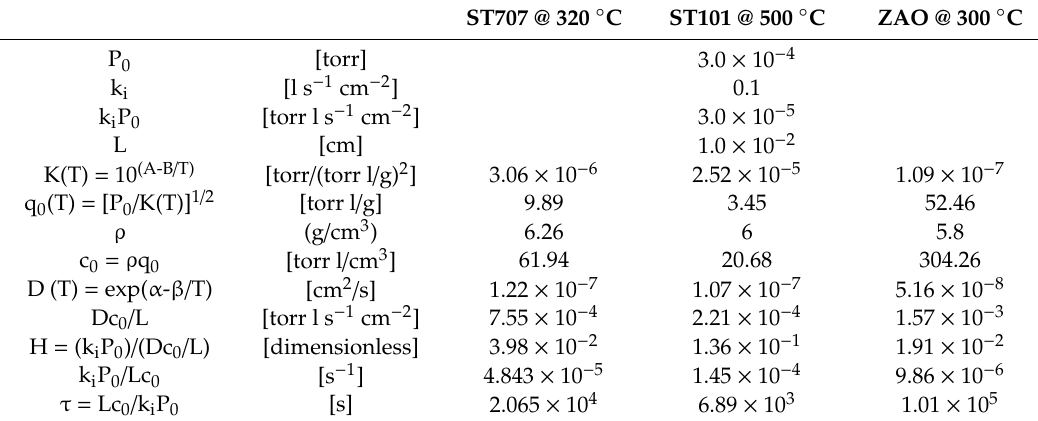
Table 3. Coe ffi cients used to establish the flux regime for the three di ff erent alloys (units are not in the SI but reflects the ones typically used in pumping